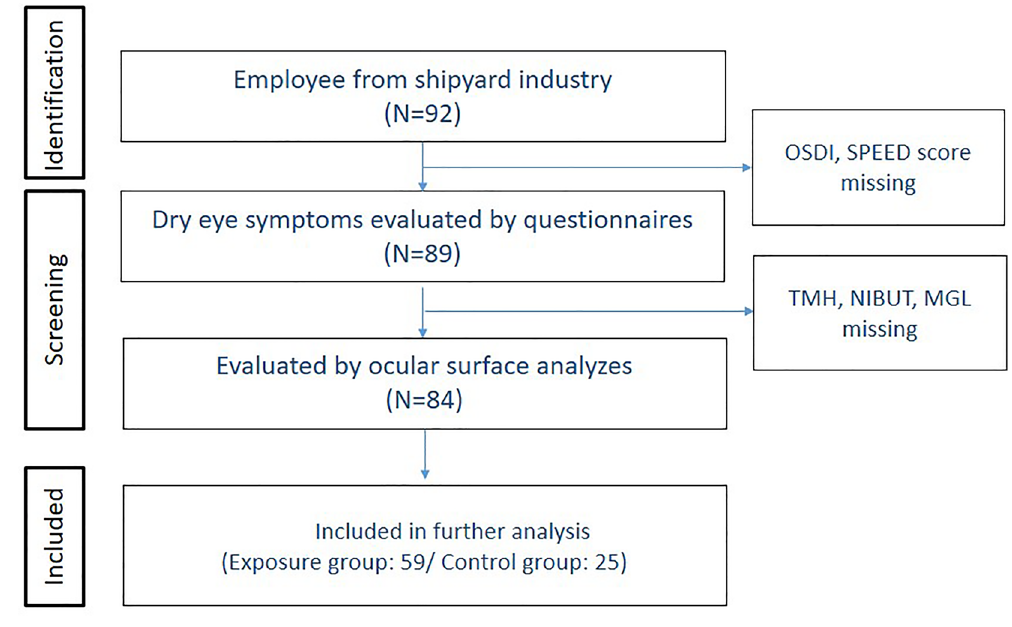
Figure 1. Flow chart of the